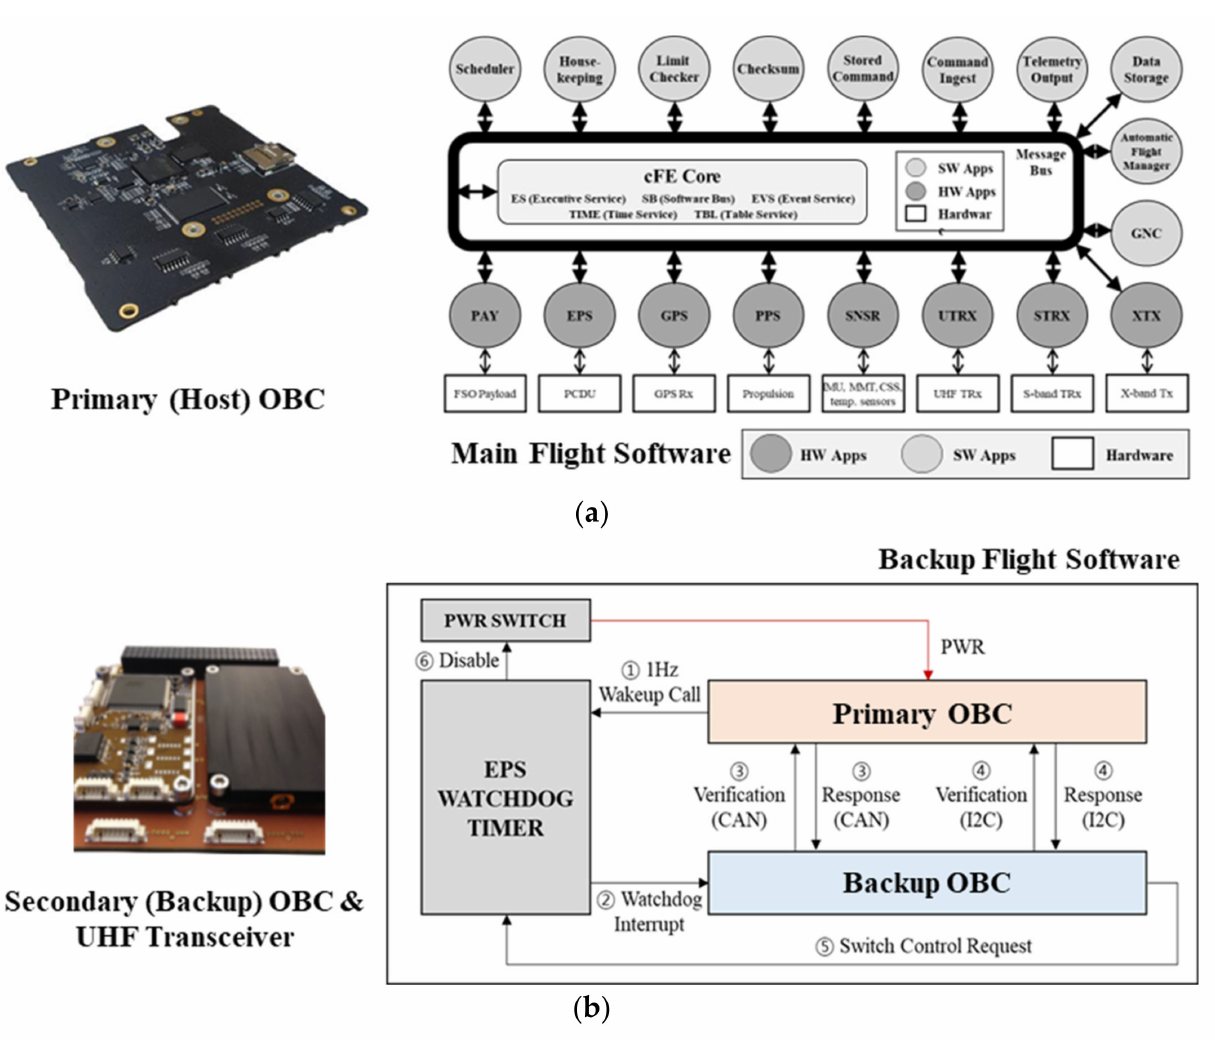
Figure 19. Diagrams and configurations of the flight software architecture and on-board computer: ( a ) the primary on-board computer and the cFS-based flight software architecture. Each application is managed on the software message bus; ( b ) the back-up on-board computer and the flight software handover procedure. The primary OBC sends a wakeup to the EPS watchdog timer every 1 sec,